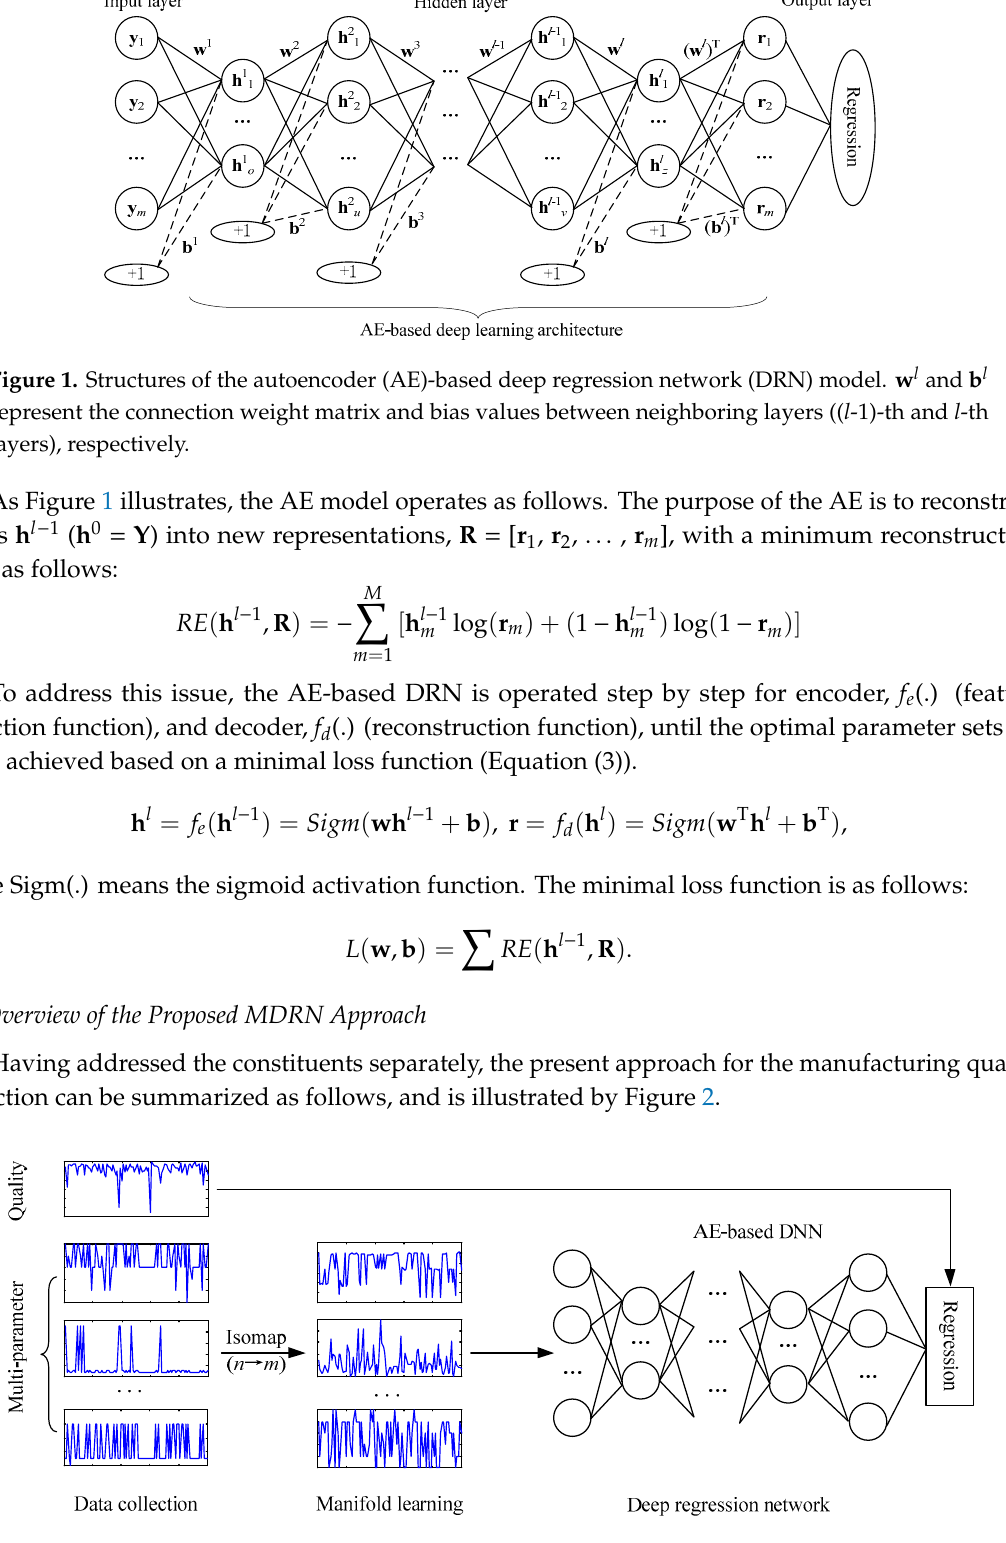
Figure 2. Flow chart of the proposed manifold learning-based deep regression network (MDRN) approach for multi-parameter manufacturing quality prediction.